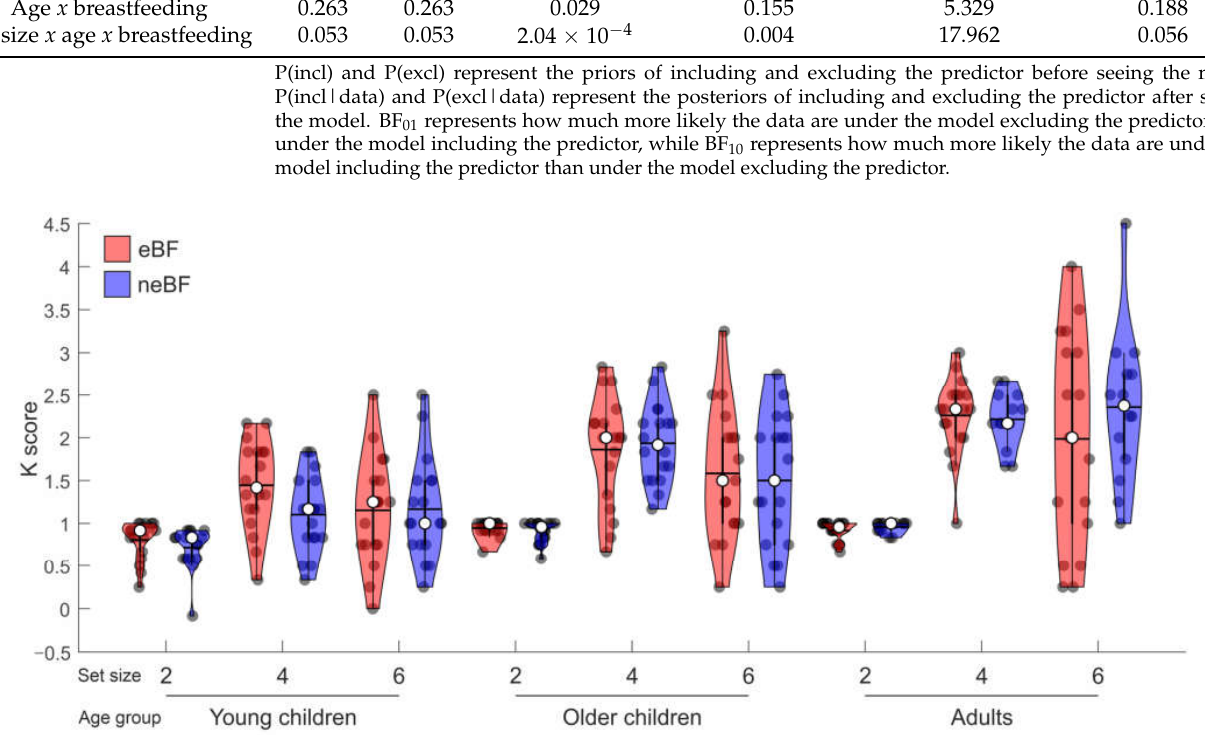
Figure 3. Violin graphs displaying the participants’ performance at the CCT as a function of the set sizes, age groups, and pattern of nutrition during 0–6 months of life. For each violin, the dark circles represent the individual performance; the median and mean of the distribution are represented by the white circle and the horizontal bar, respectively.